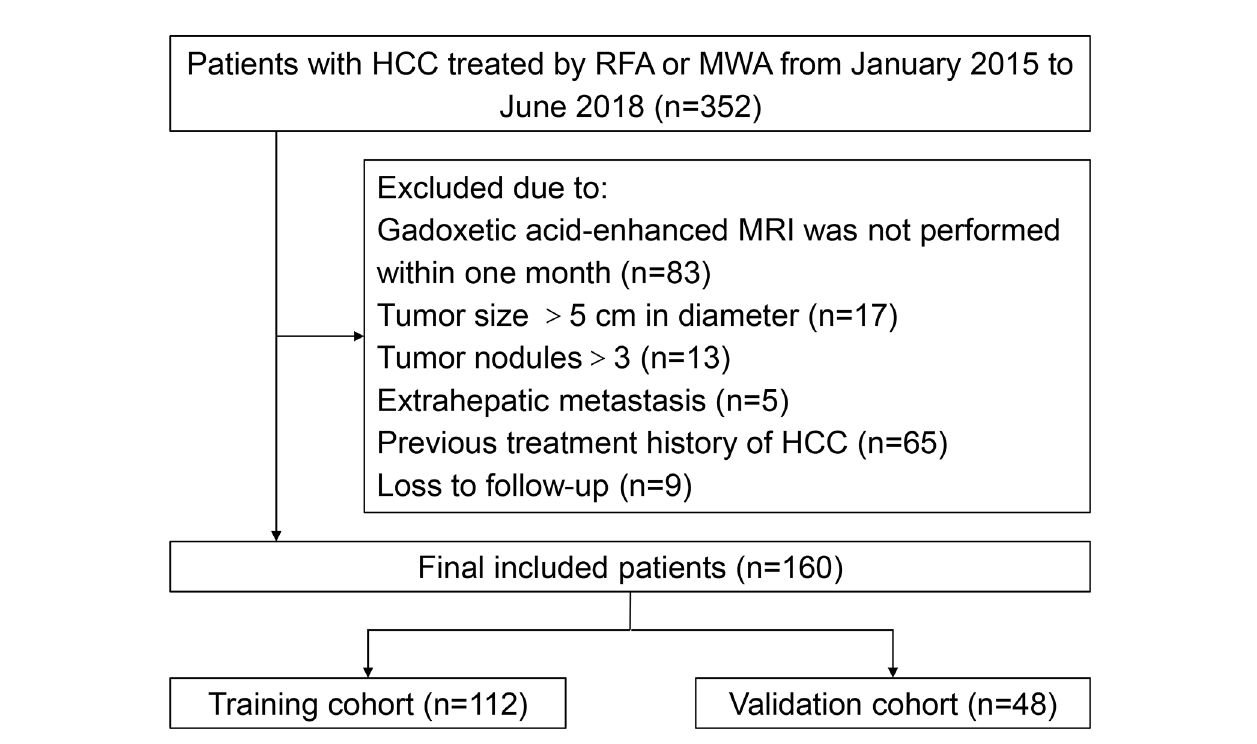
FIGURE 1 | Flowchart of patient